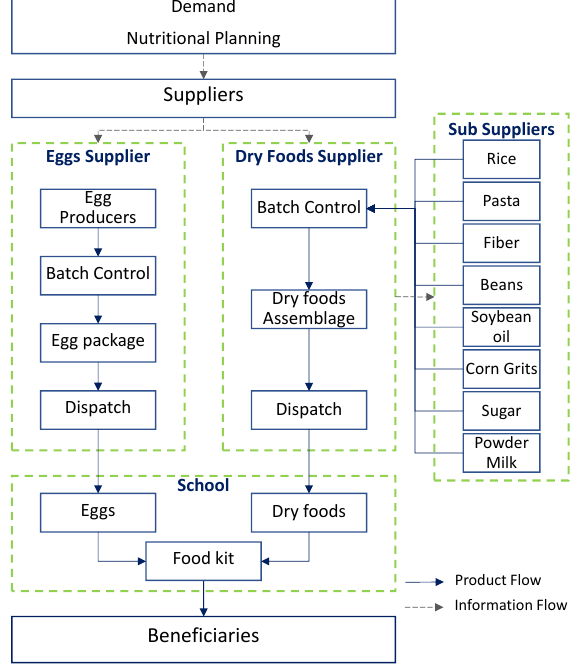
Figure 4. The structure of the supply chain of the food kit for Vitória City.